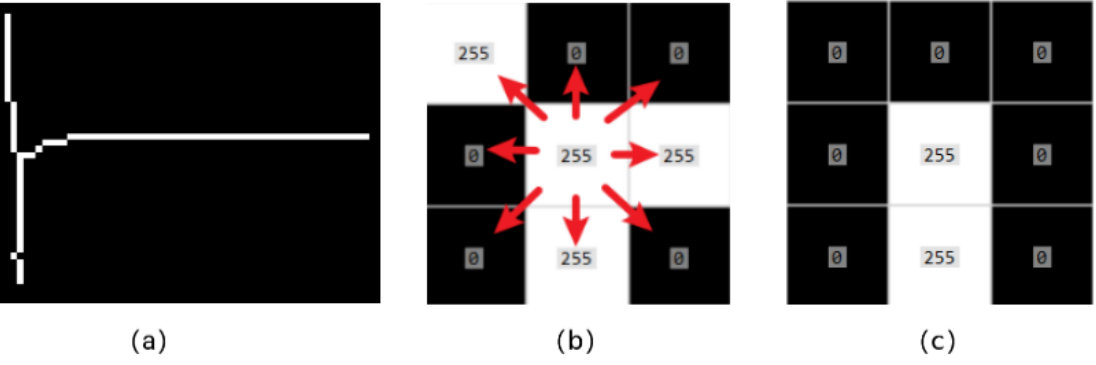
Figure 8. Detection of endpoints and crosspoints. ( a ) Rosenfeld skeleton line; ( b ) Crosspoint; ( c ) Endpoint.